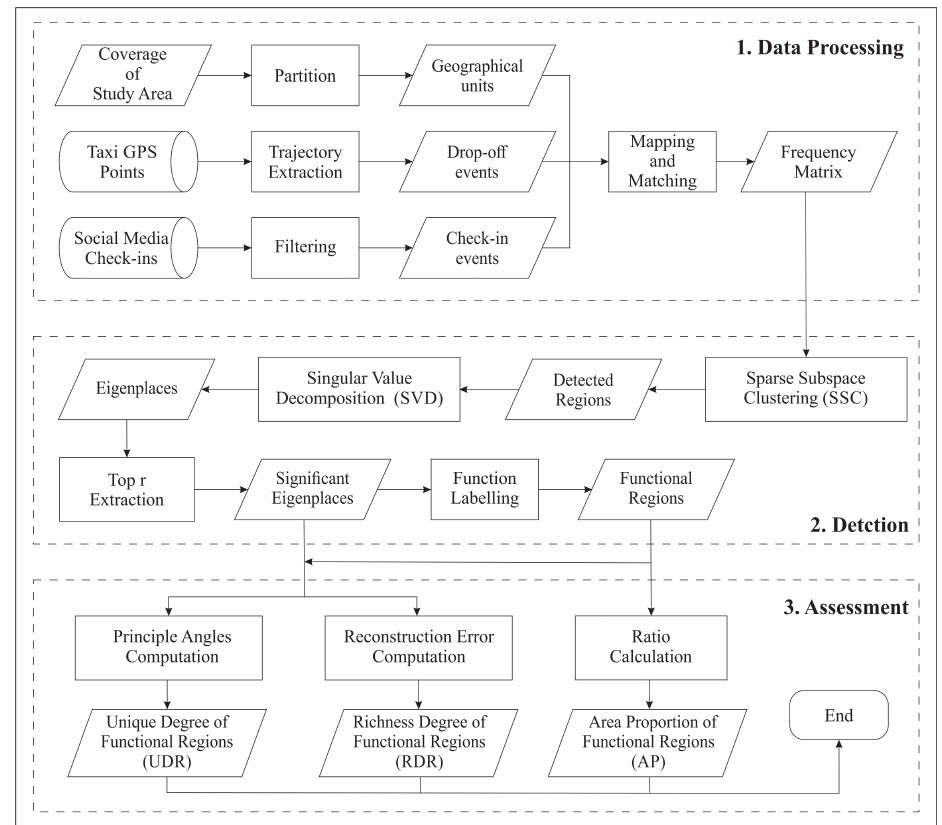
Figure 1. Workflow of the proposed model in this